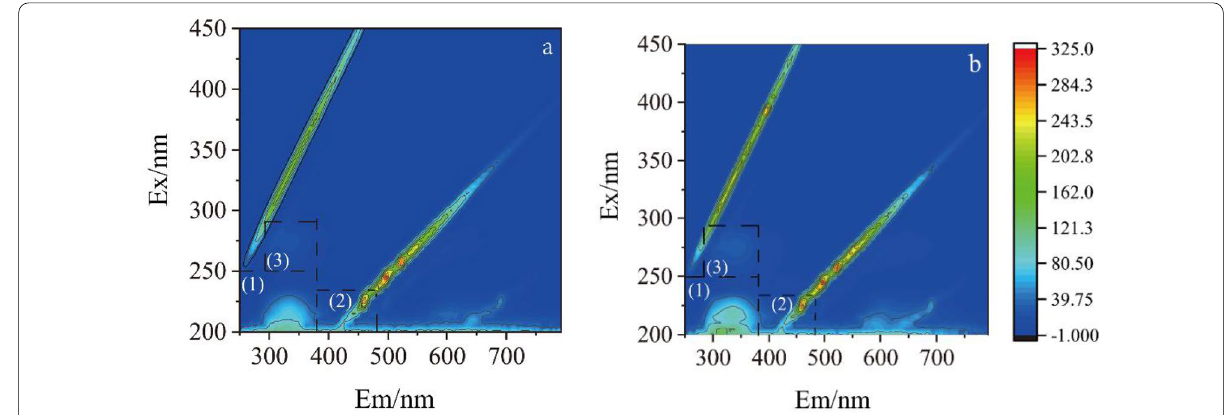
Fig. 6. 3D-EEM of extracellular polymeric substance. a without CdS NPs; b with CdS